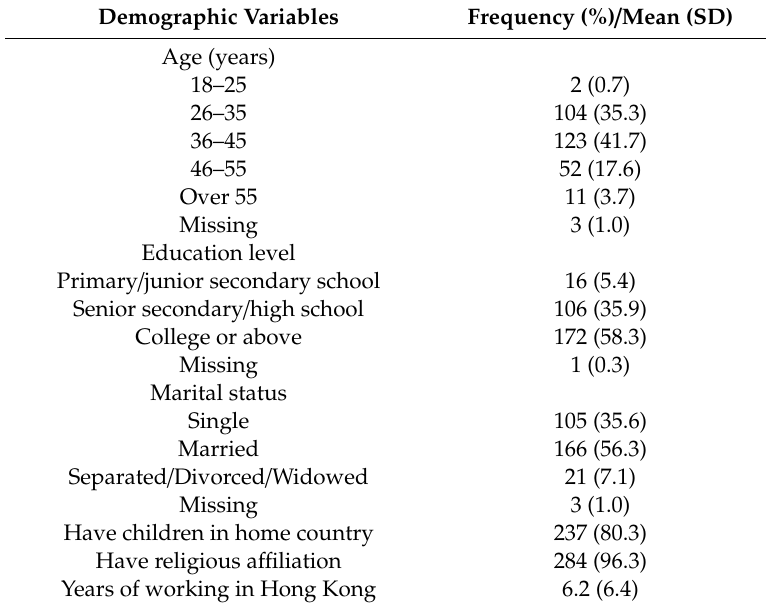
Table 1. Characteristics of the participants ( n =